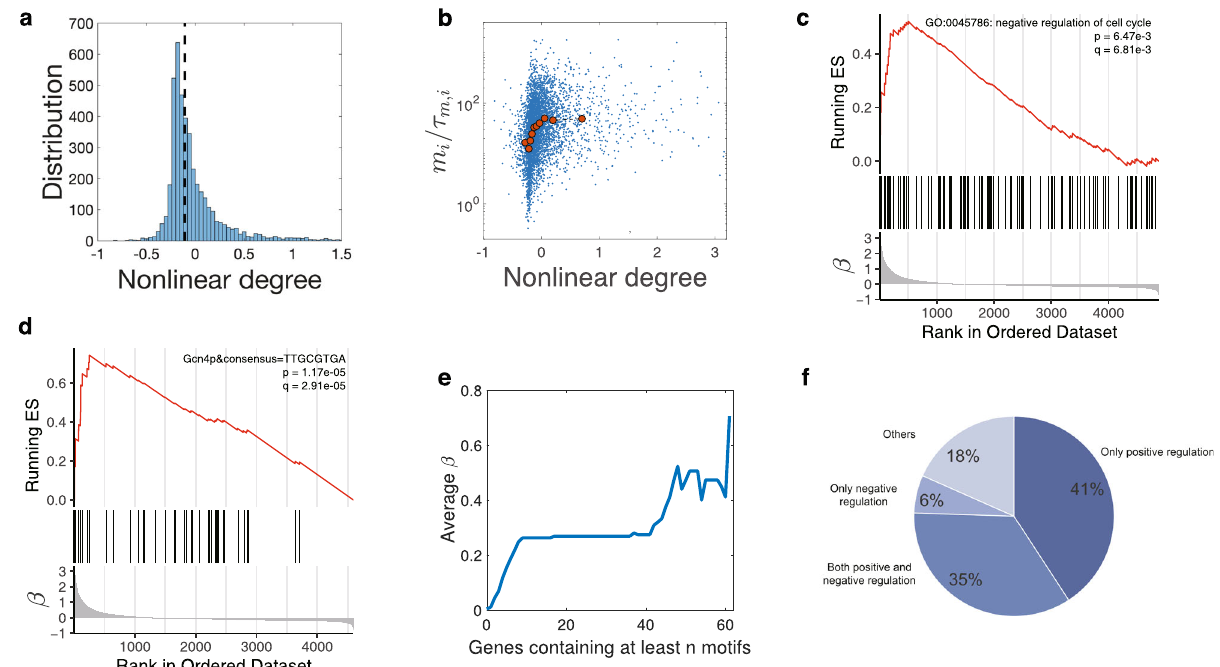
Fig. 4 Analysis of experimental data. a Distribution of the nonlinear scaling degrees of mRNAs of S. cerevisiae among genes. The dashed line marks the location of the median value of the nonlinear degrees. We consider genes with − 1 < β < 3.2, including 95% of all the measured genes. b The Pearson correlation coef fi cient between the nonlinear degrees of mRNAs and the mRNA production rates is 0.17 (two-sided Pearson correlation test, p value < 2.20e-16). The red data points are median values after binning. For the same data, the Spearman correlation coef fi cient is 0.35 (Spearman correlation test, p value < 2.20e-16). c Genes annotated as negative regulation of cell cycle are enriched in the sublinear regime. In the bottom panel, genes are ordered by the nonlinear degree β from positive (sublinear) to negative (superlinear). In the middle panel, the vertical lines represent the locations of the cell-cycle inhibitors. The upper panel shows the running enrichment score (ES) for the gene set, where the score at the peak is the ES for this gene set. The top-right legend includes the p value and the FDR q value of GSEA. d An example of a motif that is enriched in the sublinear regime. Here, the vertical lines in the middle panel represent the locations of genes containing the particular motif in the promoter sequences. Note that the motif also appears in the weakly superlinear regime but diminishes in the strongly superlinear regime. e We pick out all 77 motifs enriched in the promoters of sublinear genes and calculate the average β over genes with at least n motifs. f The functions of transcription factors associated with the 77 motifs enriched in the sublinear regime. Positive regulation of transcription by RNA polymerase II (GO:0045944) is enriched with p value = 2.41e-32. The 76% positive regulation is not likely generated from random sampling (single-sided hypergeometric test, p value =